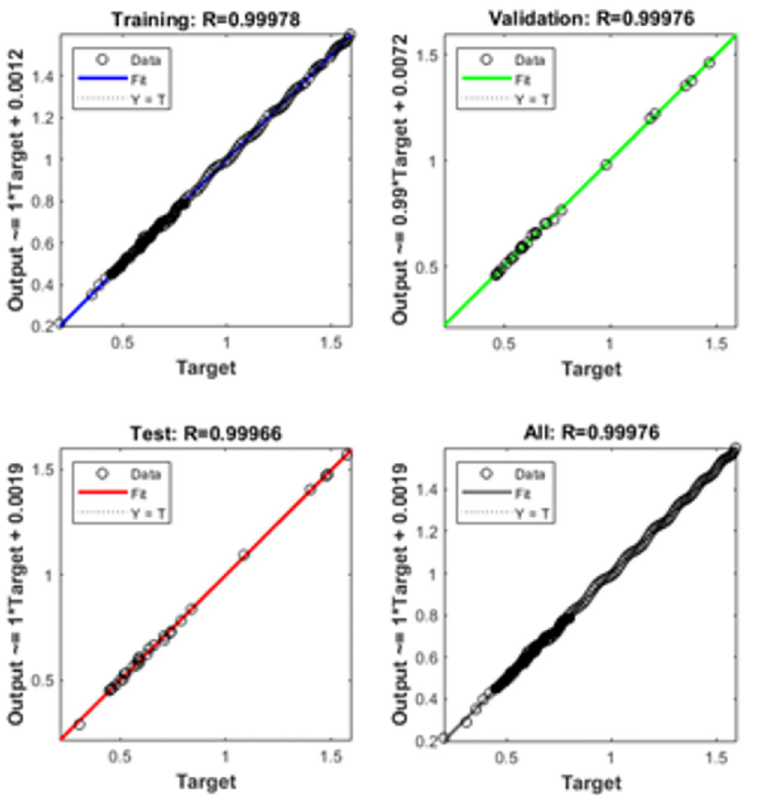
Fig 6. Regression actions for solving the infection FONPPS of Case